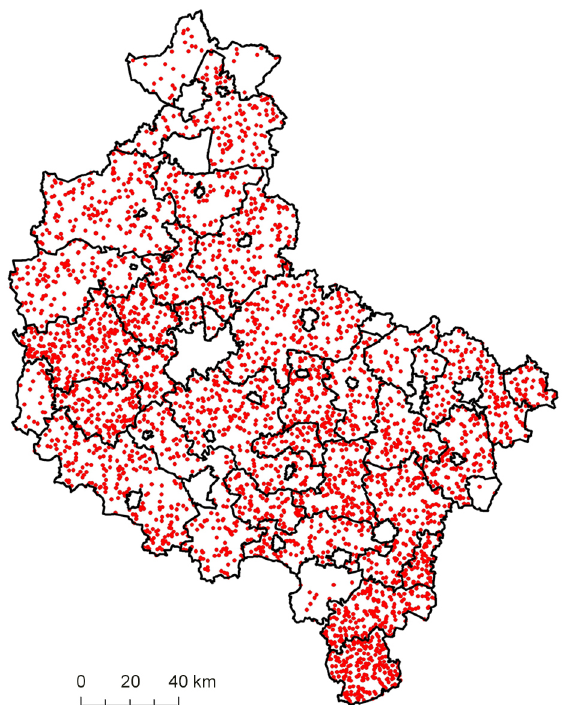
Fig. 4. Number of projects